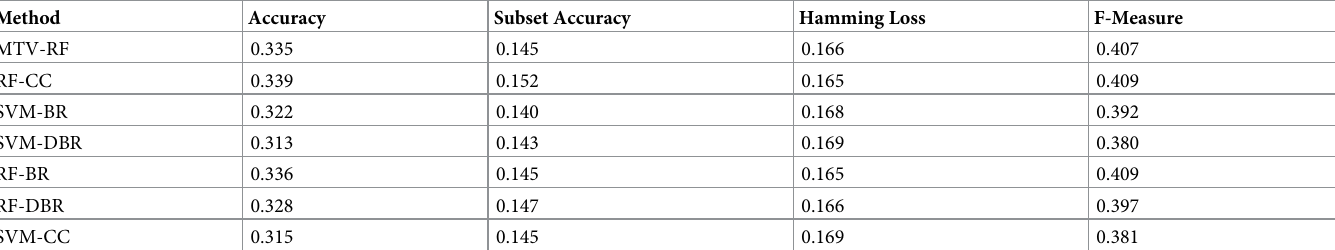
Table 2. Prediction performance